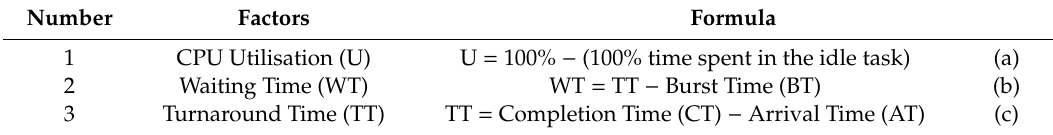
Table 2. Factors of optimal selection of Virtual